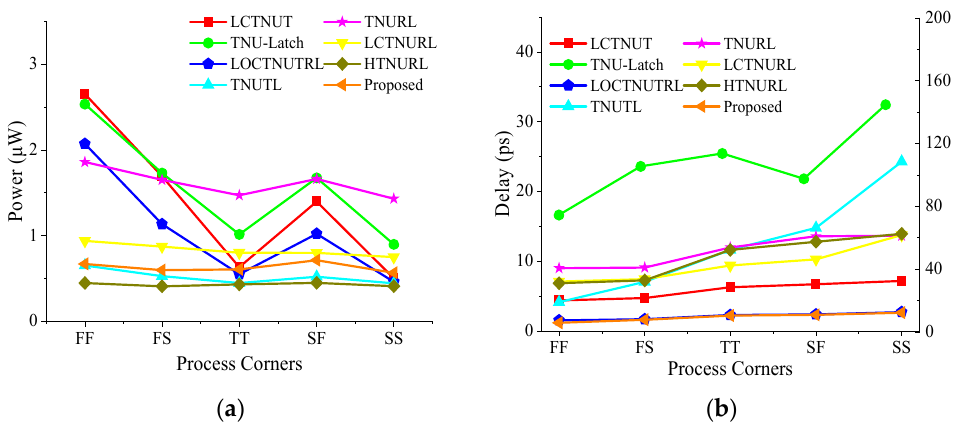
Figure 13. Process variations effect on the latches’ performances: ( a ) process corners vs. power; ( b ) process corners vs. delay.